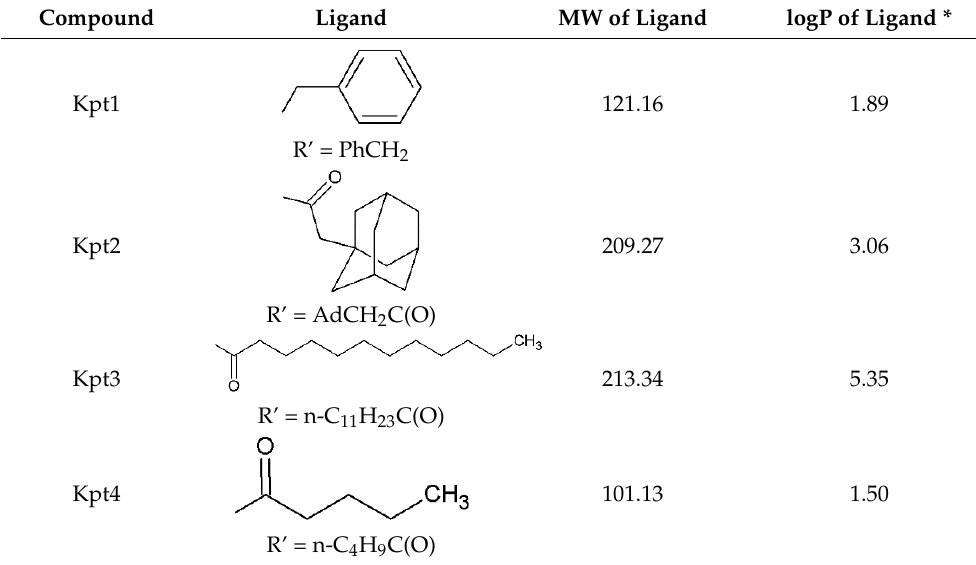
Table 1. Structures and properties of Kpt ligands.